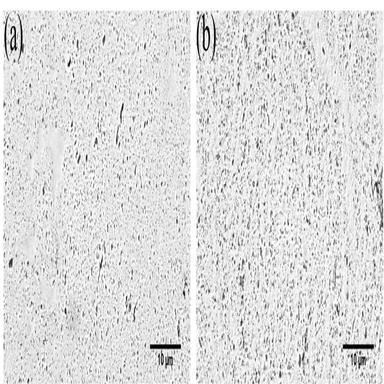
Comparison of the microstructures of the samples produced by (a) SPS process (b) and arc melting. Both structures contain boron phase finely distributed in the copper matrix.